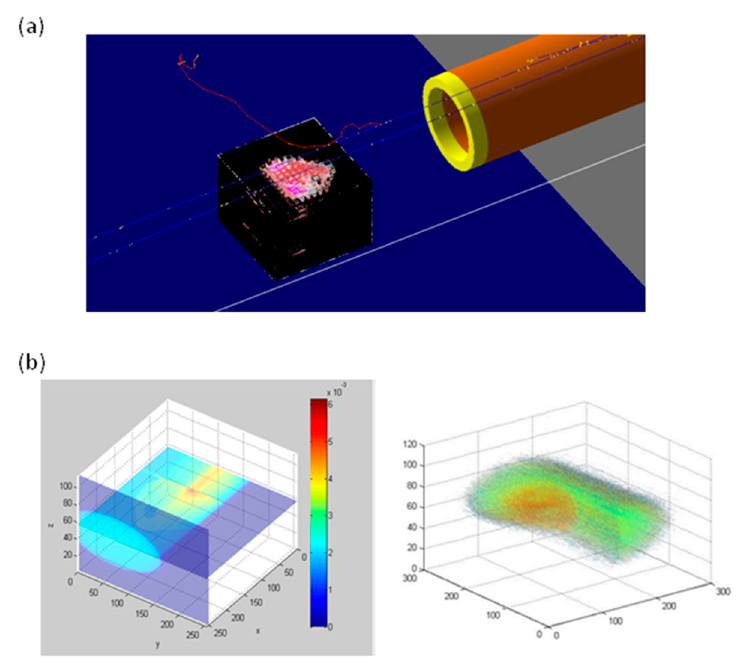
Figure 1. ( a ) Screenshot of DICOM volume in GEANT4. ( b ) Example of dose distribution calculated by Monte Carlo application.